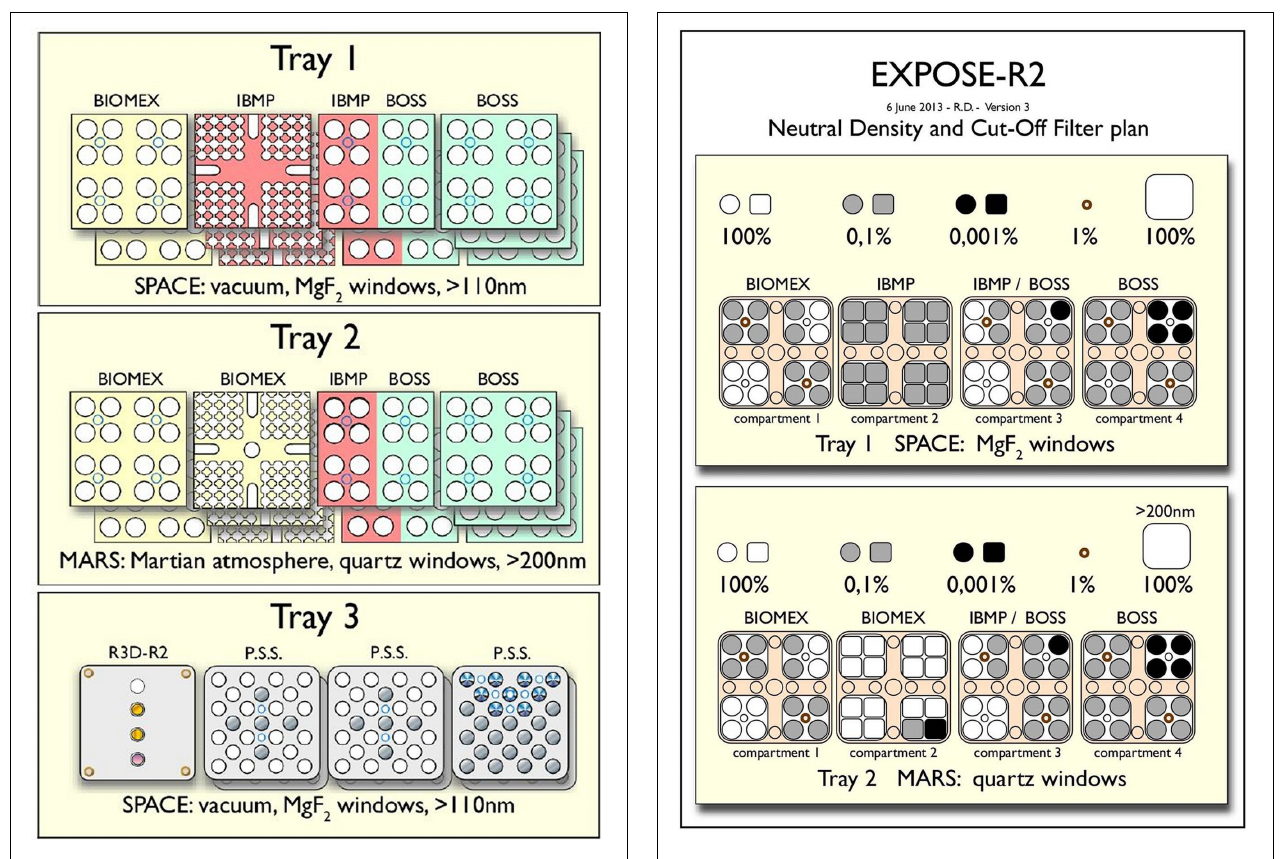
outside the Zvezda module during EVA-39 on August 18, 2014.